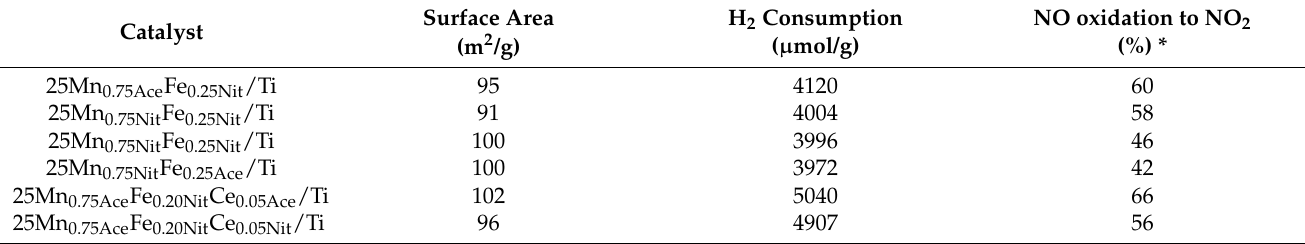
Table 2. Surface area, H 2 -TPR (temperature-programmed reduction with hydrogen) and NO oxidation results.